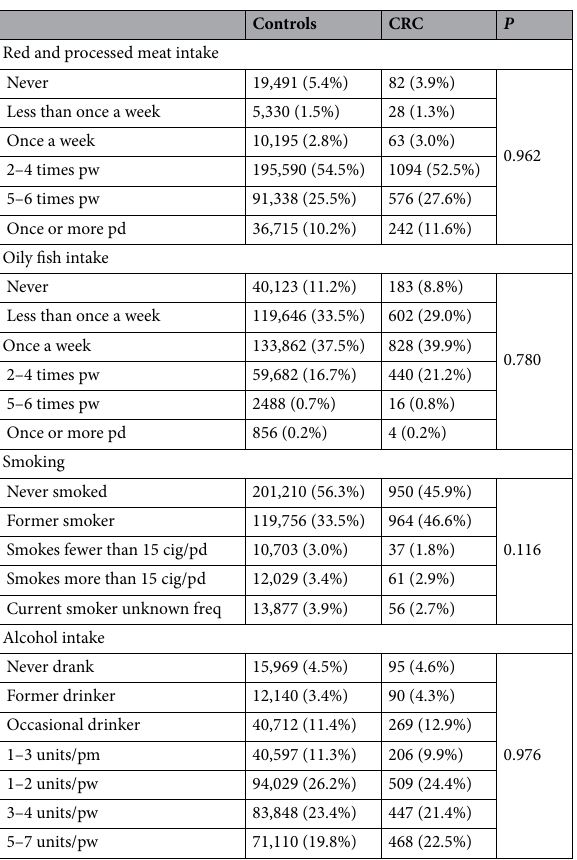
Table 1. Sample characteristics of the baseline data displaying the group means for continuous measures, distributions, and counts and percentages of categories for categorical and ordinal measures. Significant p-values are displayed in bold. CRC colorectal cancer, CSE certificate of secondary education, CVD cardiovascular disease, GCSE general certificate of secondary education, HNC higher national certificate, HND higher national diploma, IBD inflammatory bowel disease, DI deprivation index, NVQ national vocational